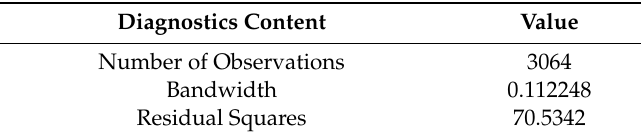
Table 7. Results of the GTWR